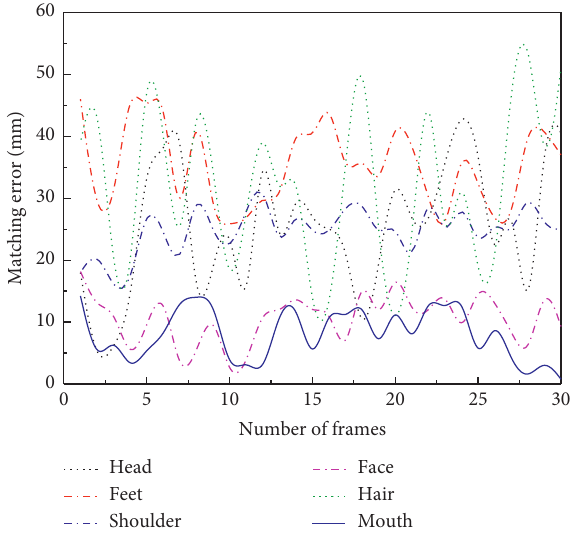
Figure 7: Matching error results for each part of human error motion when using a local optimization